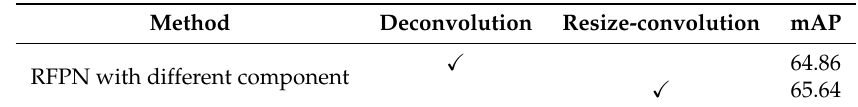
Table 4. Results of ablative study of different component for up-sampling in our proposed Refine Feature Pyramid Network on the DOTA dataset.